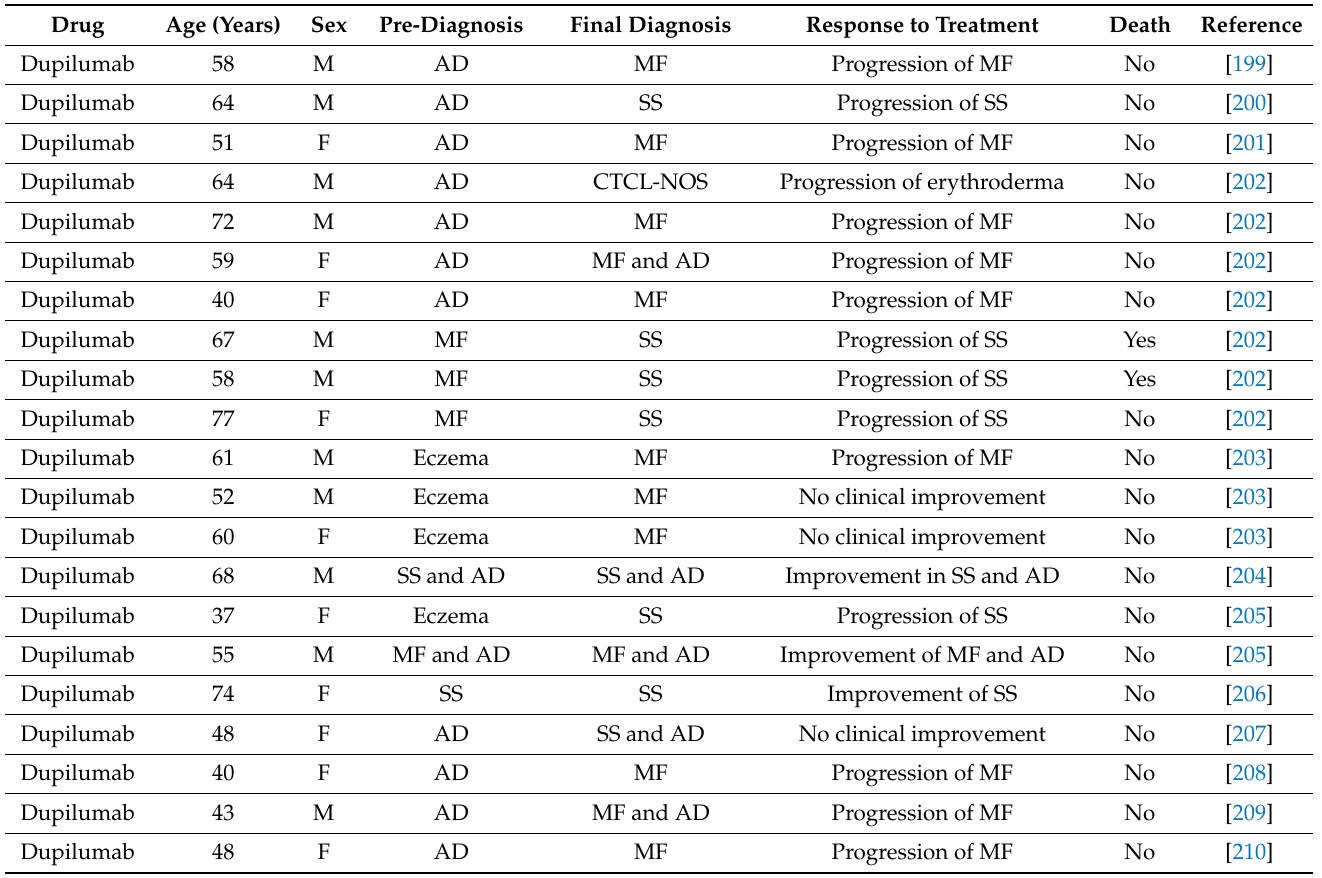
Table 2. Cutaneous T-cell lymphoma cases treated with dupilumab or ruxolitinib. We have updated the table continuing the results by doctor Sugaya